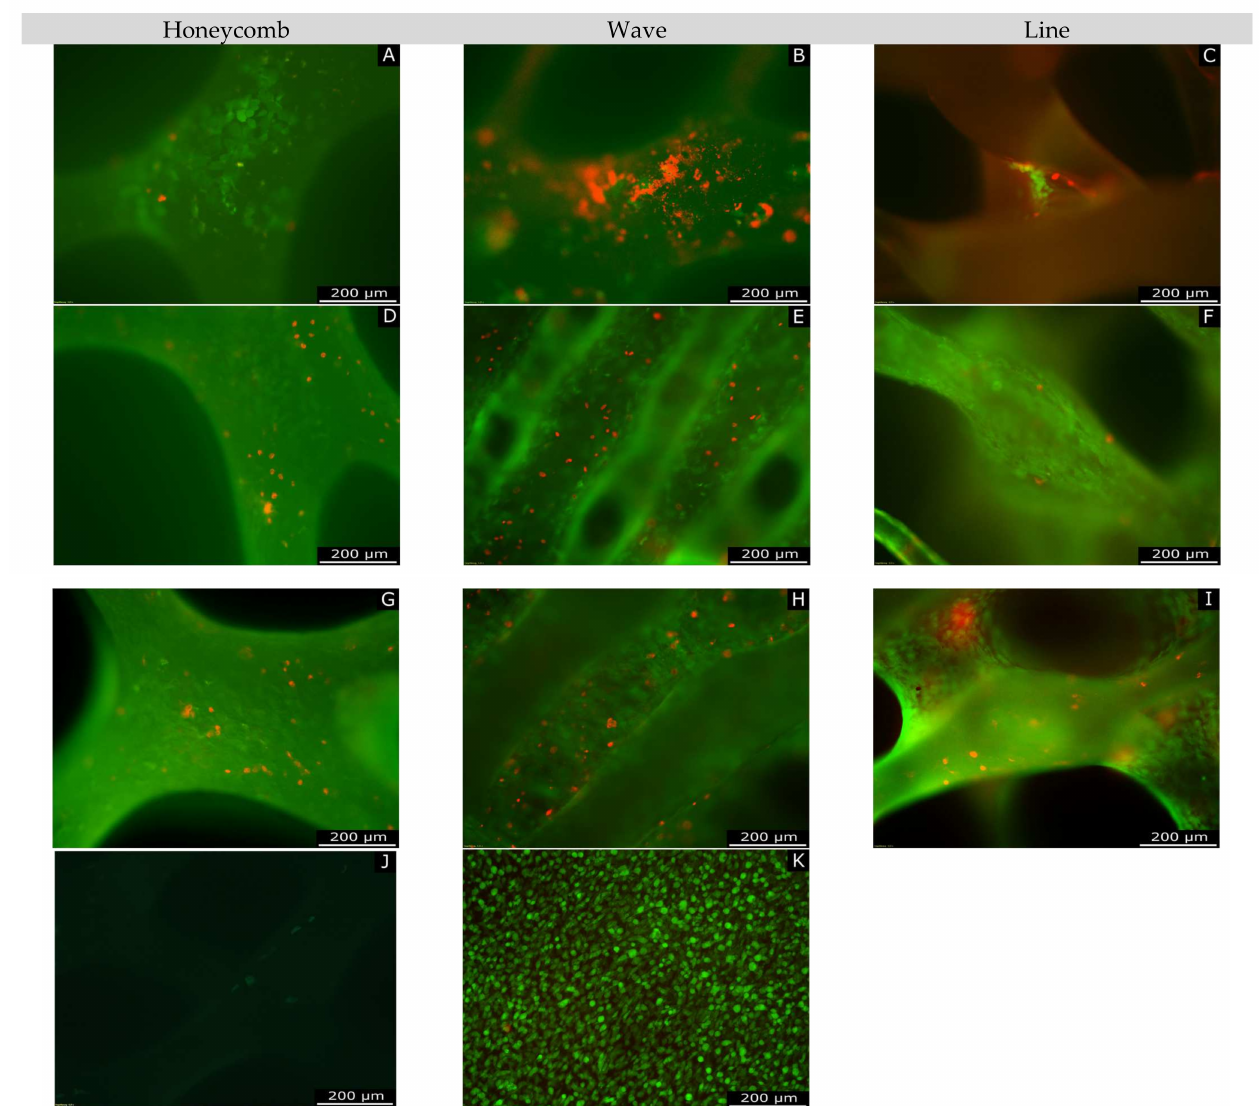
Figure 11. Overview of live/dead staining; ( A – C ): day 3; ( D – F ): day 7; ( G – I ) day 10; ( J ): intrinsic fluorescence of scaffolds; ( K ): Thermanox coverslip on day